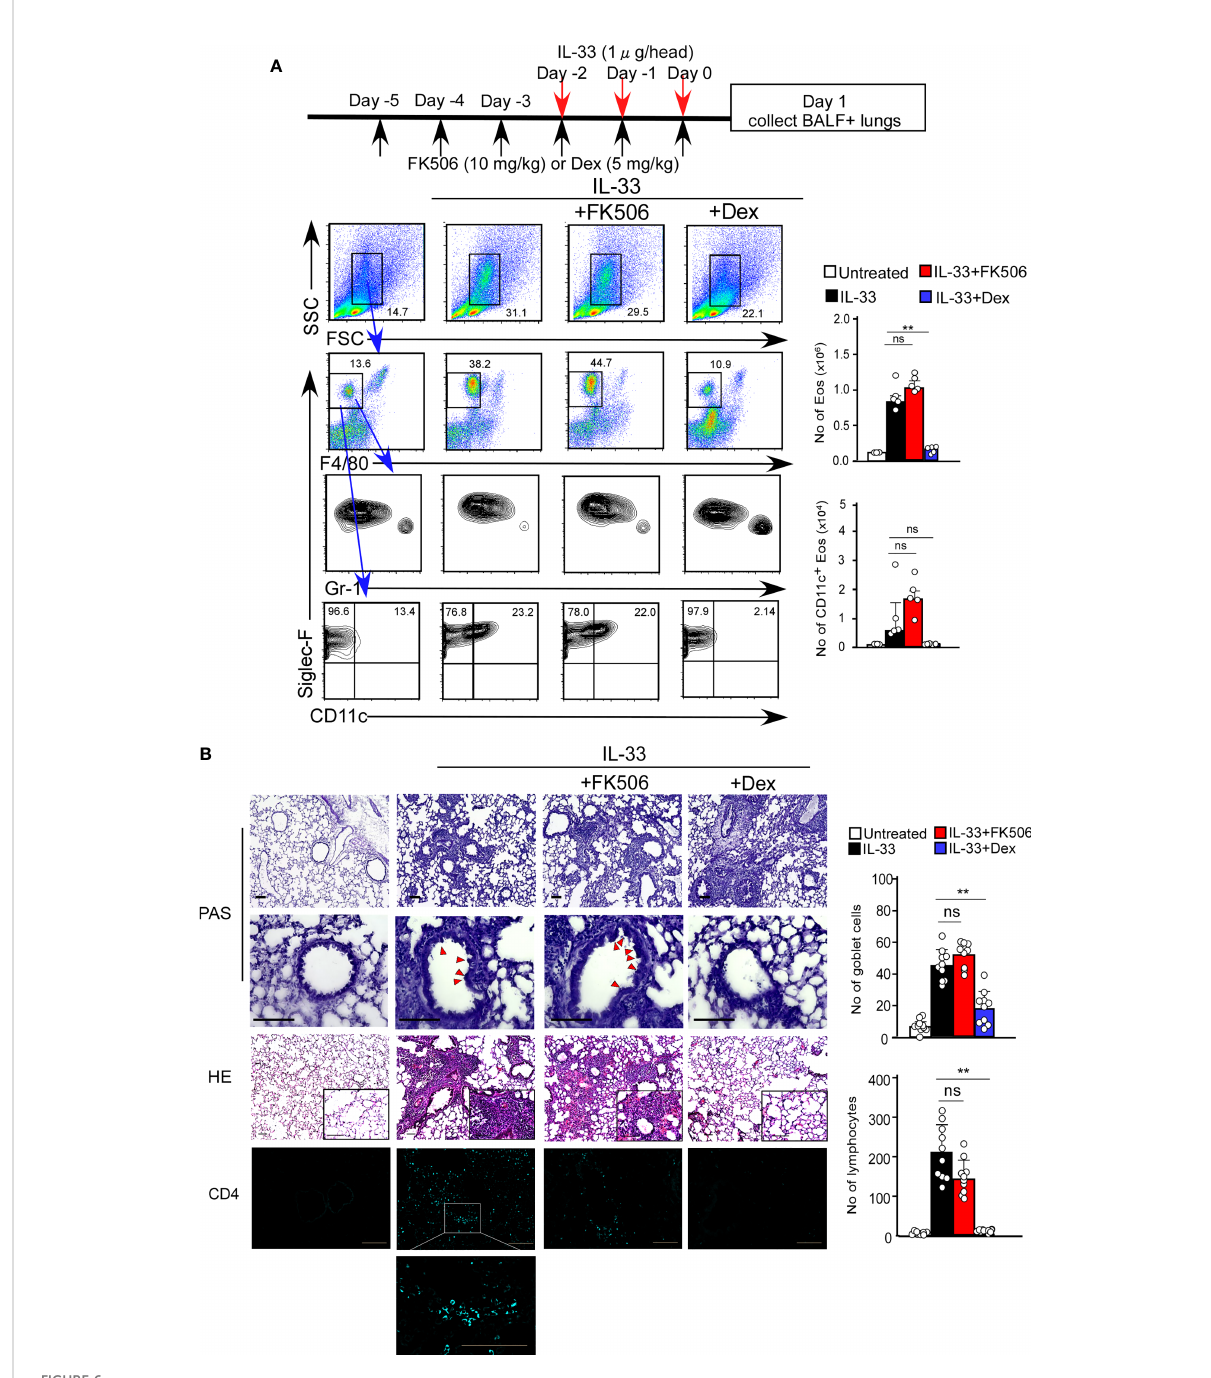
FIGURE 6 (A) The IL-33 and FK506 or Dex treatment protocol is presented by the schematic diagram (top). IL-33-administered mice (black bars, n=5) were treated with FK506 (red bars, n=5) or Dex (blue bars, n=5). Lung cells were harvested on day one after the fi nal papain administration. The data indicated the percentages (left fl ow data) and the numbers (right graphs) of Eos. (B) PAS (top: low magni fi cation; second from top: high magni fi cation), HE (second from bottom) and CD4 (bottom, right blue) staining of the lung sections, and were analyzed by fl uorescence microscopy (low magni fi cation, x20; high magni fi cation, x100; Scale bars, 100 µm). Goblet cells and lymphocytes were counted in 200 µm × 200 µm regions in each lung section (bar graphs, n=10). Red arrow heads indicate mucus glycans positive goblet cells. Bars represent the means; not signi fi cant (ns), **p – 0.01 using unpaired Mann-Whitney U-tests. All error bars represent the SEM. Data are representative of three